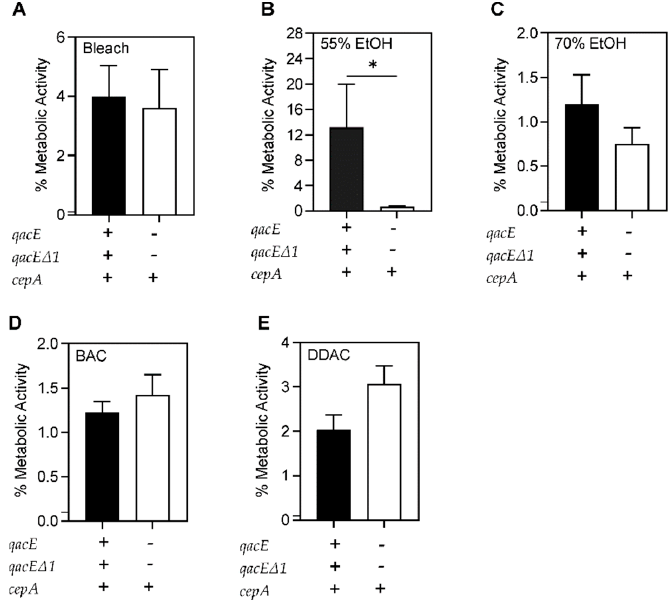
Figure 7. Comparison of survival of bacterial biofilms formed by microbicide-resistant and -susceptible strains. Average percentage of metabolic activity of four microbicide-resistant and six microbicide-sensitive strains. No significant differences were seen between resistant and sensitive strains after ( A ) 4 min of bleach exposure. ( B ) Significantly more microbicide-resistant bacteria survived compared to sensitive strains after 1 min of 55% ethanol exposure ( p = 0.04). No significant differences between resistant and sensitive bacteria were seen after ( C ) 1 min of 70% ethanol, ( D ) 2 min of 0.5% BAC, and ( E ) 1 min of 0.61% DDAC exposure. The average metabolic activity of is displayed and error bars represent the standard deviation. A p -value of ≤ 0.05 was considered significant. * p -value < 0.05.